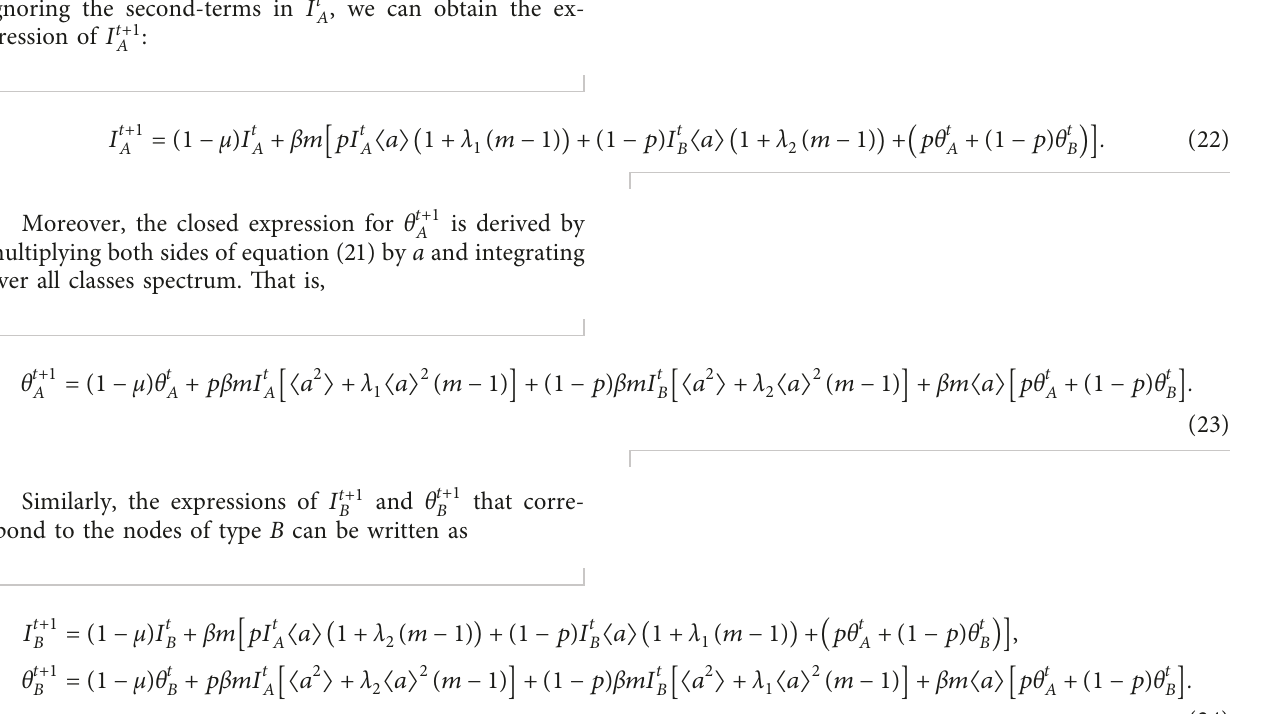
Figure 3: The conditional probability corresponding to the nodes with activity a F ( N A / B | N A ) and F ( N A / B | N B ) for the type A nodes and type B nodes, respectively. Theoretical and simulation results are labeled in the a a 1 a a 1 same manner as in Figure 2. For n � 5 , 10, and 20, ε n � 0 . 015, 0.0702, and 0.3981, respectively. Other parameters are set to be the same as those in Figure